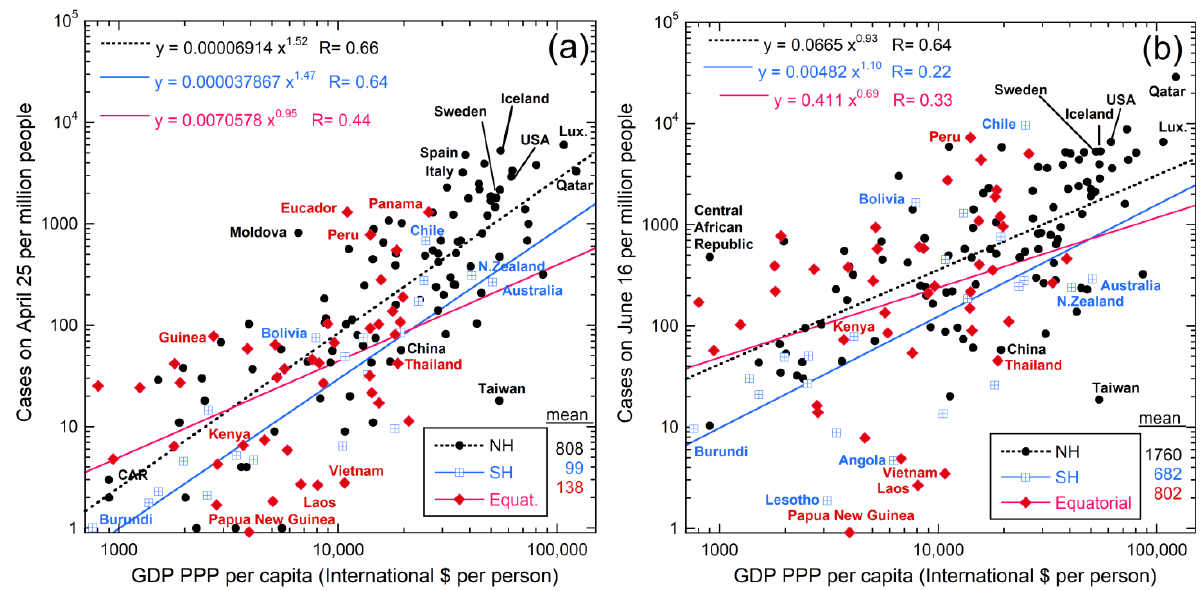
Figure 5. Log–log plot of incidence as a function of wealth of each nation, excluding city-states, small island nations and island dependencies. Data from [53,85–87]. To remove possible effects of regions with extremes of wealth or population density, we culled the city-states, countries with areas below ~800 km 2 based on [87], plus Greenland and the Falkland Islands, which are economic dependencies and are populated only along their coasts. Categories and mean values are shown in the lower right corner. The equatorial region includes countries near the equator that possess substantial (>~40%) areas of hot and wet climate zones (Af or Am classifications; see, e.g., [88]), approximately 10° N to 10° S. Upper left corner shows power-law least-squares fits with linear correlation coefficients (R). Varied growth in regions and certain countries is evident in the labels. The changes in the SH are connected with the Andean nations, despite isolation of mountainous areas: ( a ) case data from 25 April 2020; ( b ) case data from 16 June 2020. Growth in the equatorial regions was strong over the spring.